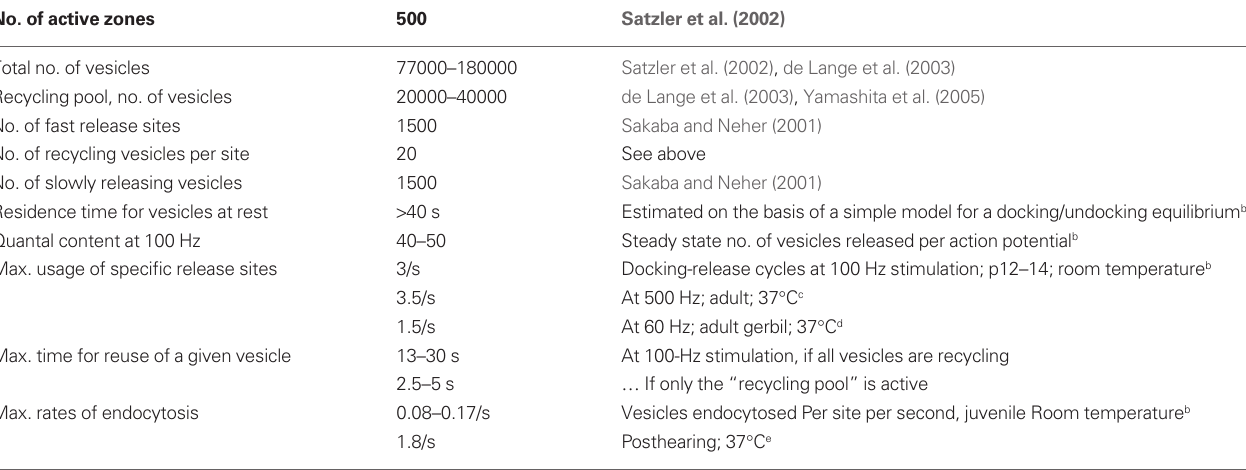
Table 1 | Kinetic and morphometric parameters a for the calyx of Held nerve